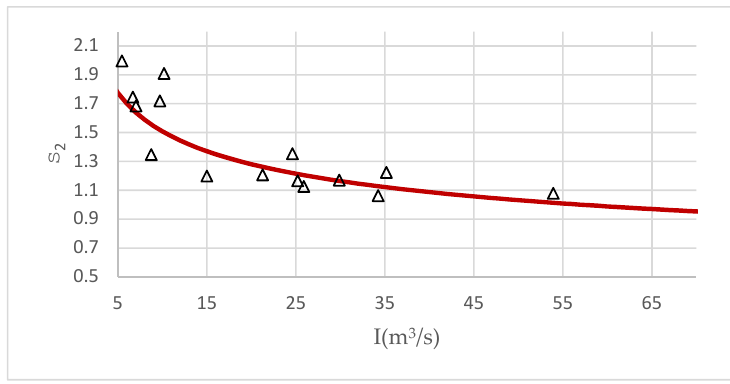
Figure 9. Empirical estimation of attenuation parameter—recession limb of the hydrograph. Tables 5 and 6 show the model performance evaluation indexes and error statistics. Table 5. Model-2 performance evaluation coefficients and forecasting error statistics (calibration data set). Lead Time (min)